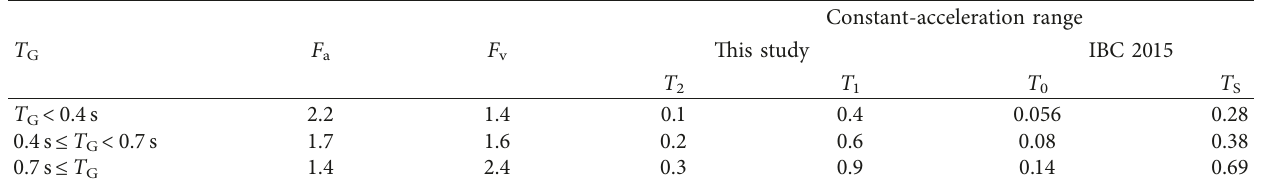
Table 7: Properties of the proposed DRS-3.